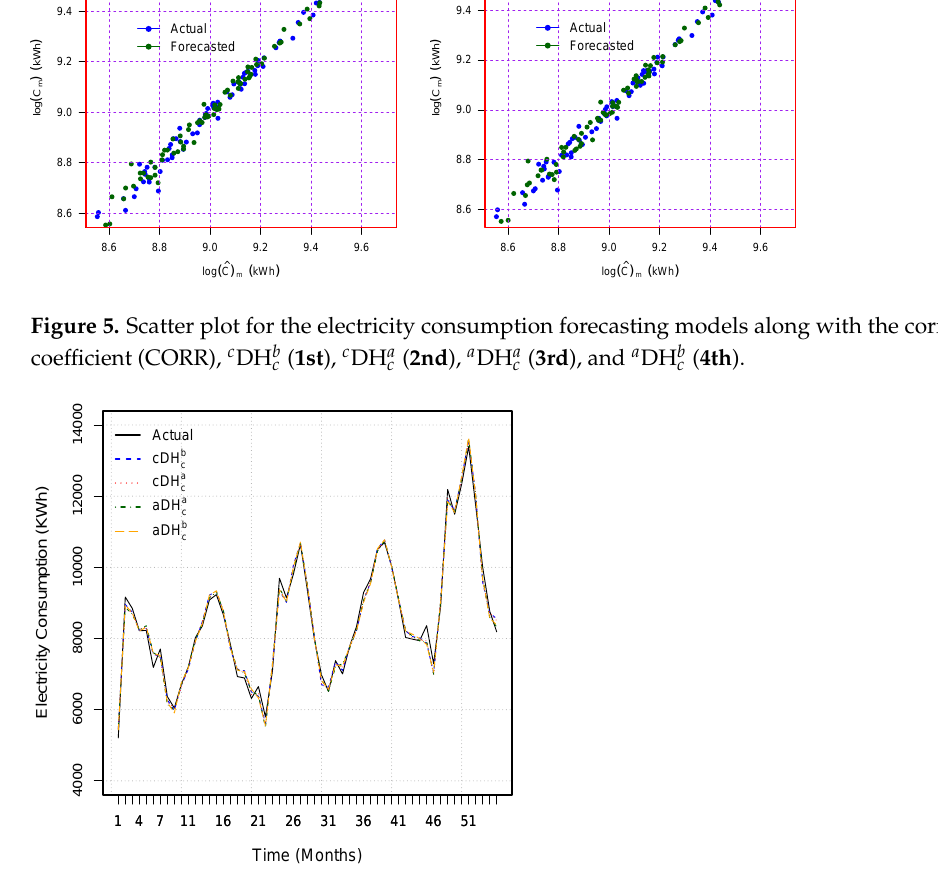
Figure 6. Original and forecasted electricity consumption for four of the best models over five